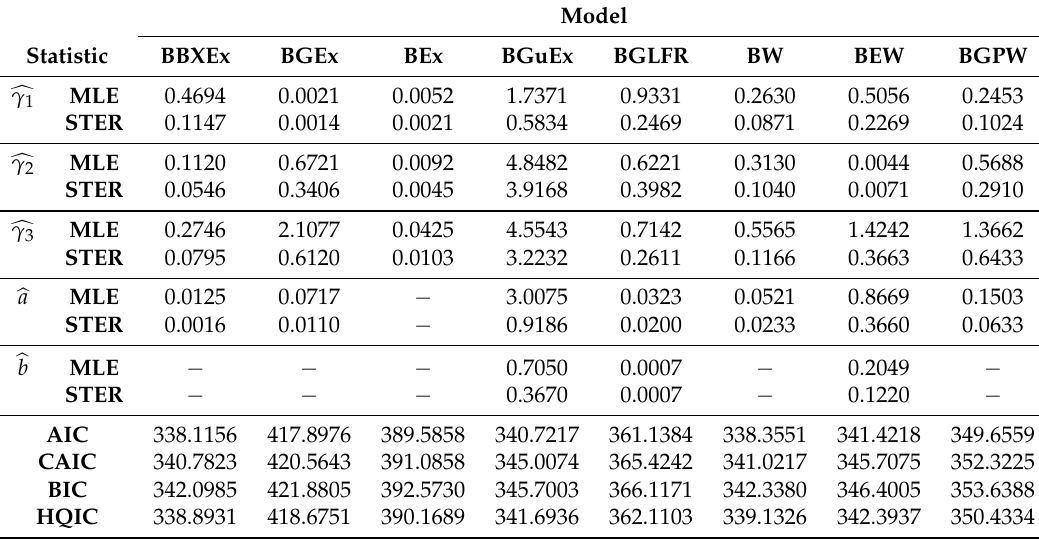
Table 10. The MLEs and goodness-of-fit measures based on Type-II censored data at r = 20 using data set